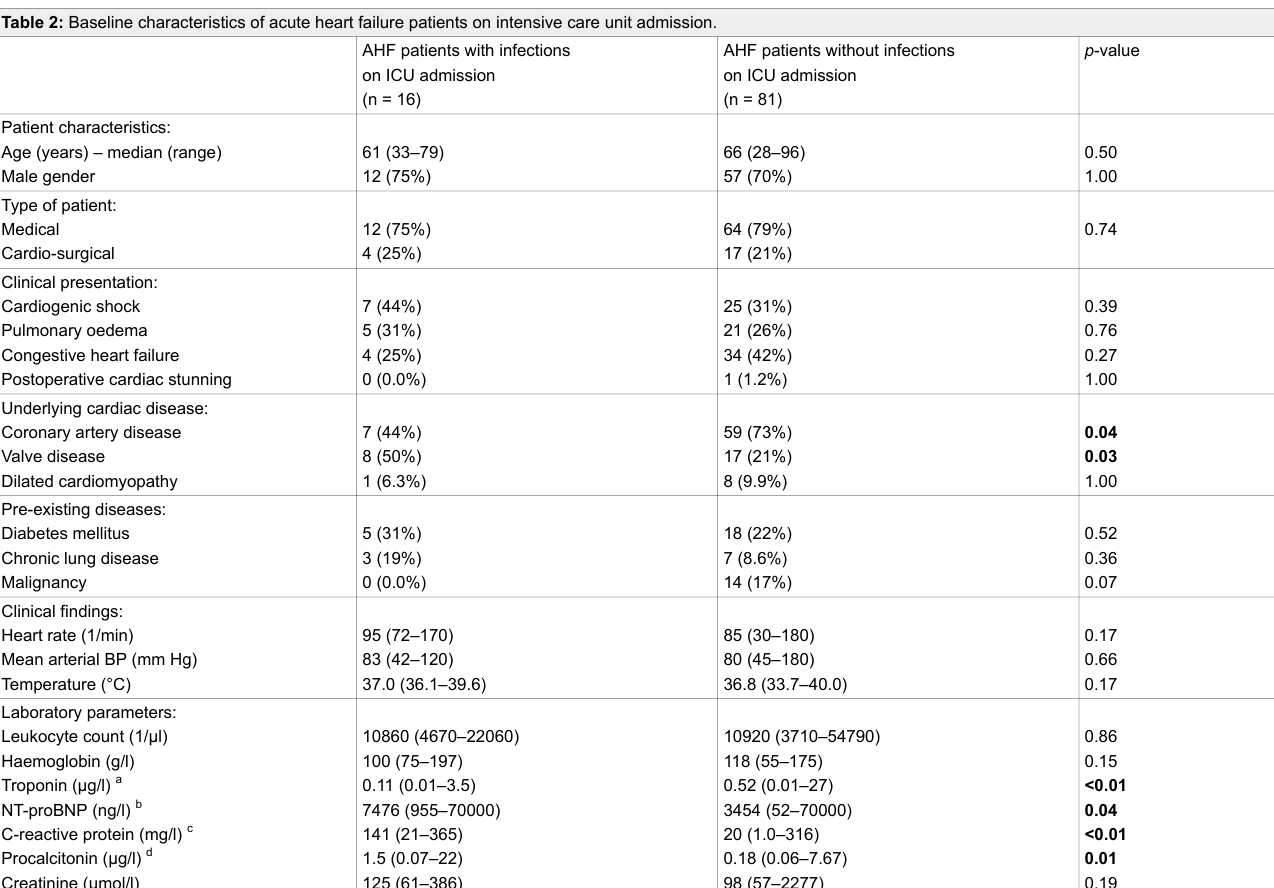
Table 2: Baseline characteristics of acute heart failure patients on intensive care unit